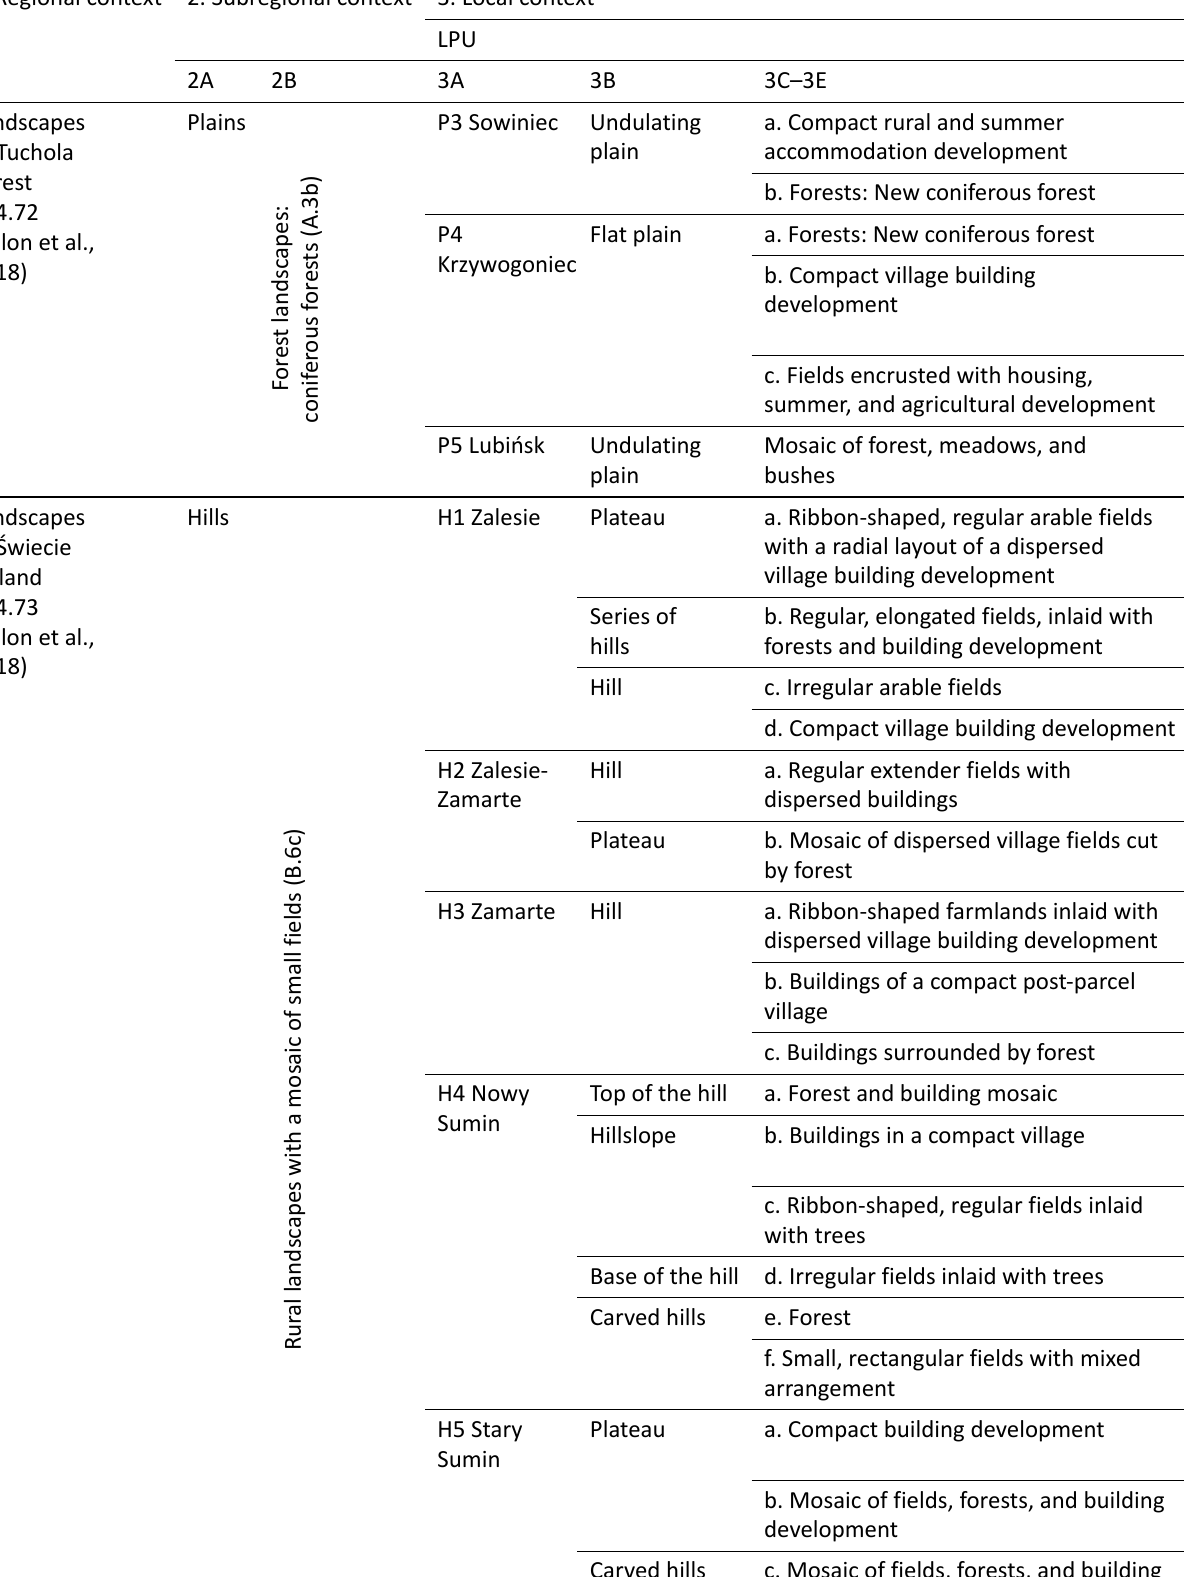
Table 2. (Cont.) Classification of the landscape units of the study area with integrated description of subunits. 1. Regional context 2. Subregional context 3. Local